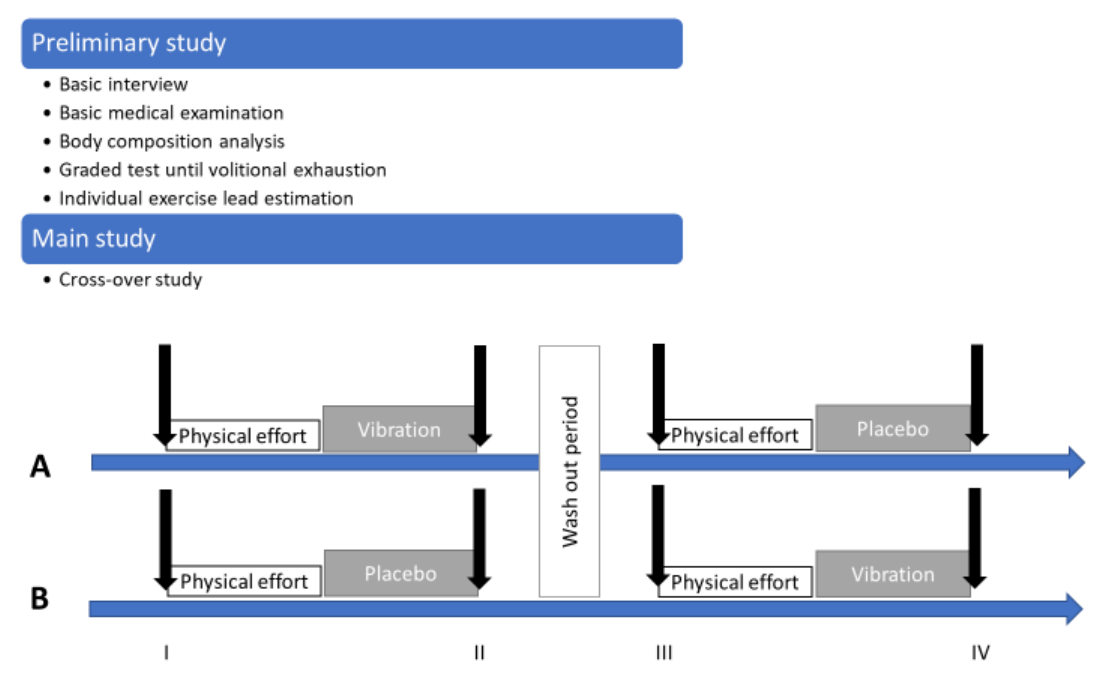
Figure 1. Study protocol with preliminary and main study details. ( A , B ) are the names of the groups taking part in the cross-over study. Black arrows represent the instants of time that blood samples were taken. Intervention type: vibration or placebo. I—first blood sampling (before physical effort); II—second blood sampling (1 h after physical effort); III—third blood sampling (before second physical effort); IV—fourth blood sampling (1 h after second physical effort).